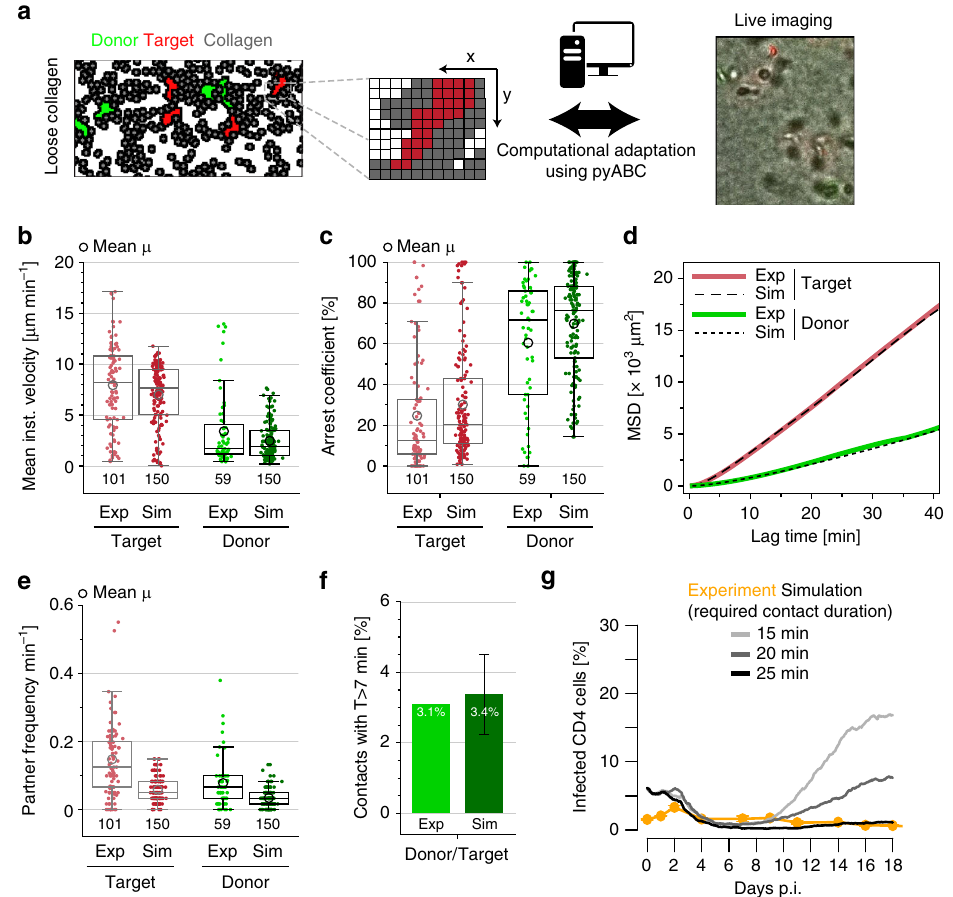
Fig. 6 Steps 6 and 7: CPM recapitulates cell migration in loose collagen and in silico spatial infection model determines minimal contact duration for productive cell-to-cell spread. a Snapshot of the CPM, which is a lattice-based model with individual cells consisting of several grid sites. Shown are loose collagen conditions with infected donor cells (green), target cells (red), and collagen (gray). The CPM is automatically adapted to live-cell imaging data using the pyABC-framework. b – d Motility characteristics showing the mean instantaneous velocity ( b ), arrest coef fi cient ( c ), and mean square displacement ( d ) of target and donor cells comparing experimental data and simulated cells. Simulated data comprise the results of one representative simulation starting with 150 donor and target cells each and followed over 1 h based on the parameterization obtained by fi tting the CPM to the experimental data. e Simulated cell tracks show comparable partner frequencies between target and donor cells. f Proportion of long-lasting cell contacts (>7 min) for donor-target contacts. g Simulated long-term infection dynamics using different assumptions for the minimal contact duration between infected and uninfected cells allowing cell-to-cell spread of infection. For each contact duration, the mean over 10 independent simulation runs is shown. Experimental data are depicted in yellow. Boxplots show Tukey style whiskers, circles indicate mean